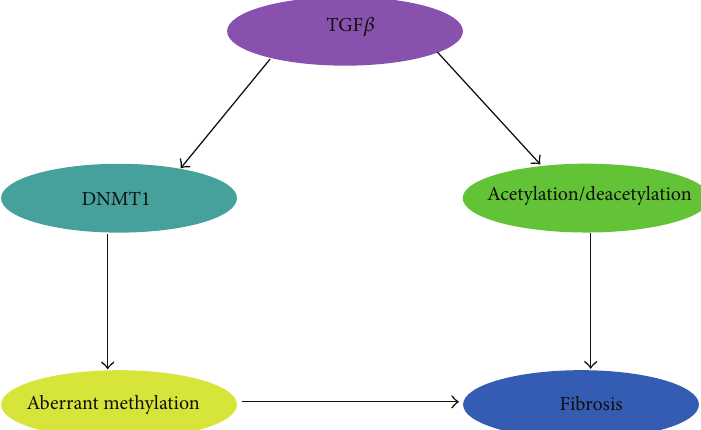
Figure 3: Epigenetic regulation of the TGF 𝛽 pathway. TGF 𝛽 has been shown to upregulate the expression of DNMT1 which causes aberrant methylation [76] leading to a more fibrotic phenotype. Furthermore, TGF 𝛽 has been shown to decrease acetylation in corneal fibroblasts causing them to remain active and leading to fibrosis [77]. In contrast to its role in corneal fibroblasts, TGF 𝛽 enhances Smad 2/3 acetylation leading to increased activity of these Smads